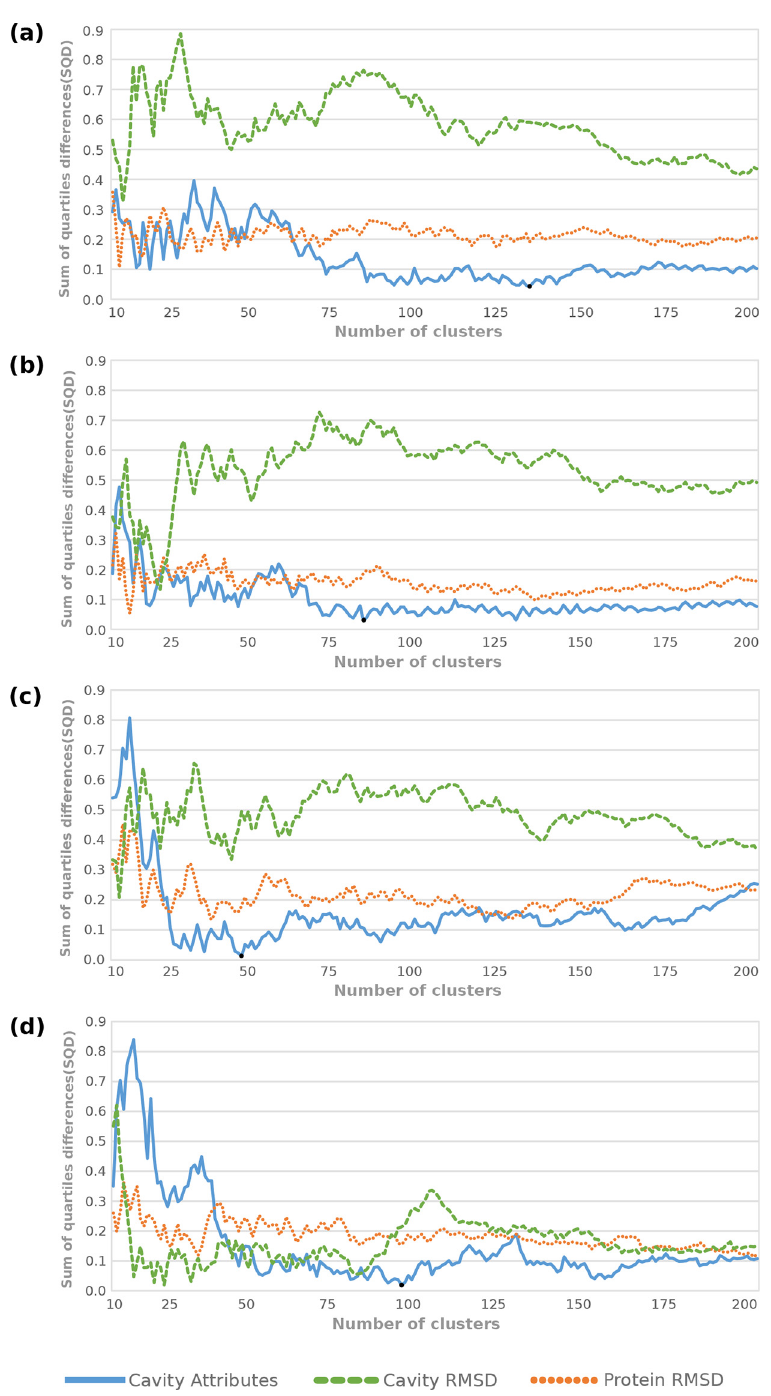
Fig 5. Comparative performance of hierarchical agglomerative clustering methods for each of the three data sets generated from the conformations of the MD trajectory. The SQD values as a function of the number of clusters for, UPGMA, WPGMA, Complete and Ward ’ s methods are showed in the graphs (a), (b), (c) and (d), respectively. The black points identify optimal partitioning